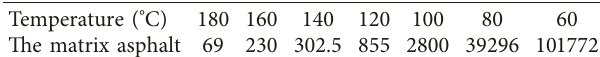
Table 1: Viscosity of asphalt at different temperatures (MPa ·